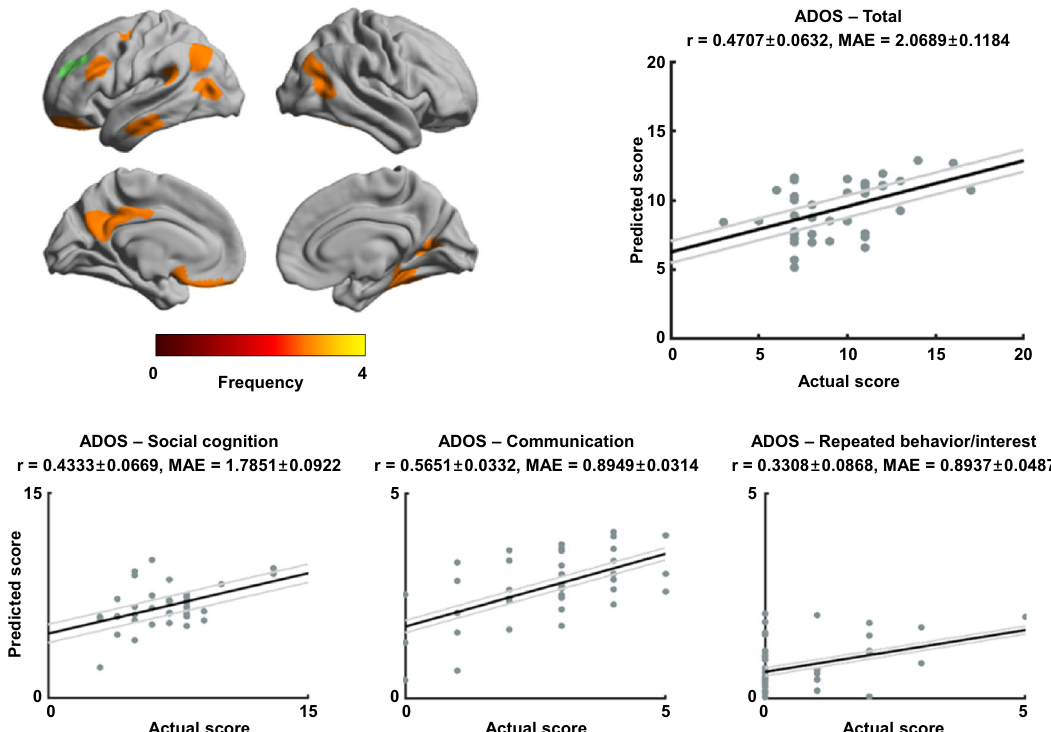
Fig. 4 Associations between structural manifolds and autism symptoms. Frequency of the selected brain regions across four ADOS scores reported on brain surfaces (top left). Correlations between actual and predicted ADOS total and subscores are reported with scatter plots. Black line indicates mean correlation and gray lines represent 95% con fi dence interval for 100 iterations with different training/test dataset. Source data are provided as a Source Data fi le. ADOS Autism Diagnostic Observation Schedule, MAE mean absolute fi ndings of connectome miswiring with molecular and neuro- physiological data that probe cortical microcircuits. By combining